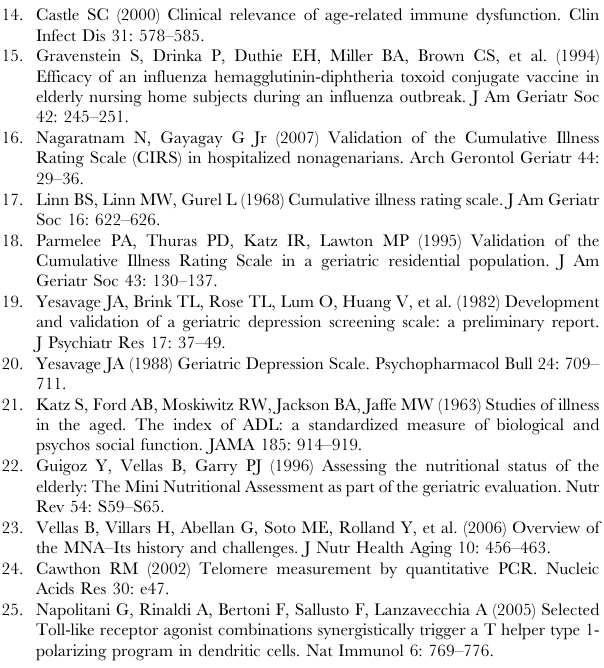
Figure S1 Activation state (CD86 and HLA-DR) of monocytes and cDCs in non frail and frail old individ- uals. Whole blood cells were stimulated or not with LPS or R848 during 5 h. Expression of CD86 (A) and HLA-DR (B) was assessed for monocytes (Lineage 2 HLA-DR + CD11c + CD14 + ), cDCs (Line- each donor are shown. The bars represent median values 6 interquartile range. (TIF)